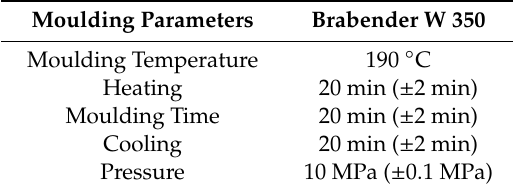
Table 2. Moulding process characteristics.